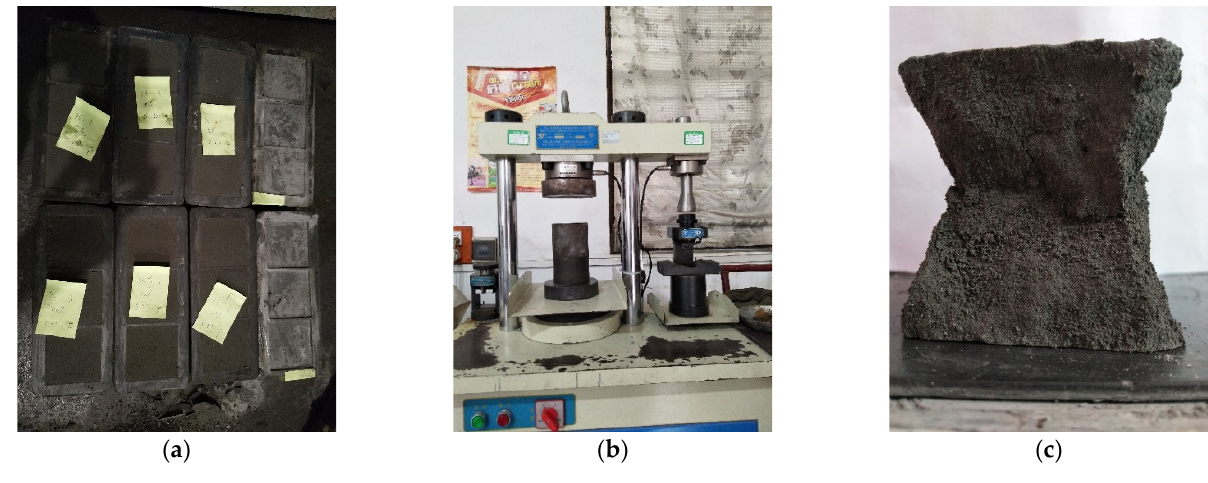
Figure 4. UCS test: ( a ) FCPB samples; ( b ) TYE-300 press machine; and ( c ) FCPB sample after the UCS test.